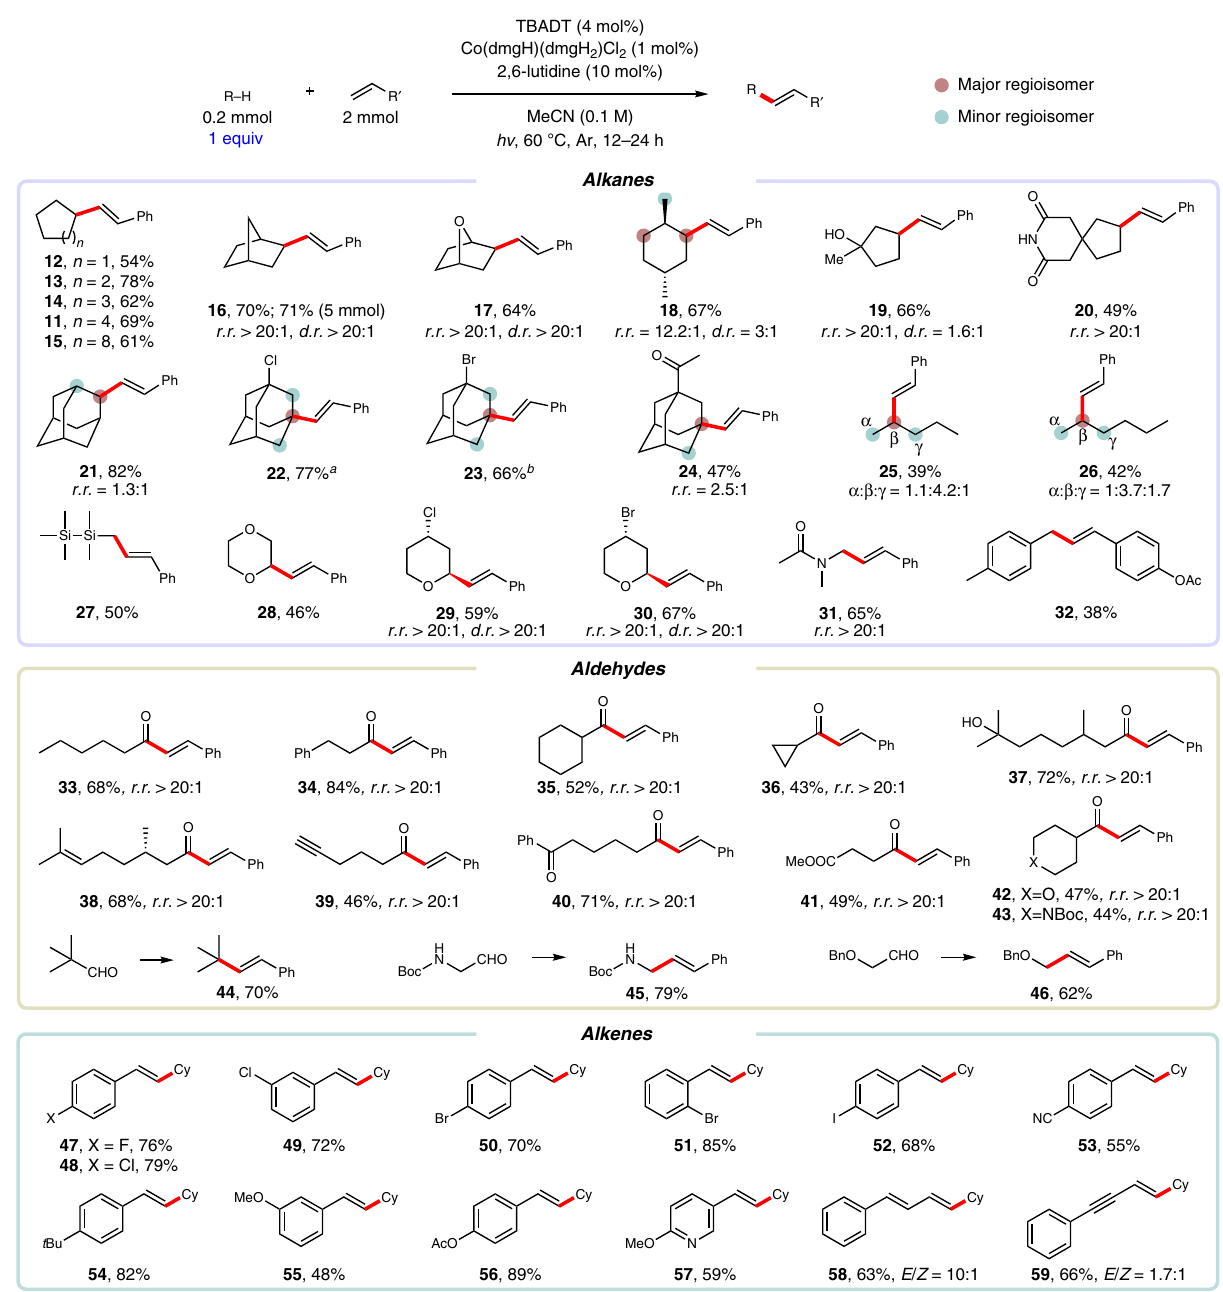
Fig. 3 Scope of dehydrogenative alkenylation. Isolated yields. E / Z > 99:1 unless otherwise noted. a 60% selectivity. b 67% selectivity. Ac = acetyl, Boc = tert -butyloxycarbonyl, Bn = benzyl, Cy =